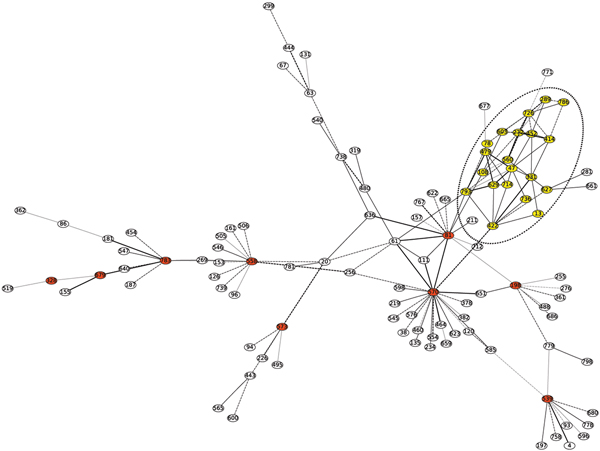
Undirected GGM network inferred from the Arabidopsis thaliana data using the algorithm of [7; 9]. The solid and dotted lines indicate positive and negative partial correlation coefficients, respectively, and the line intensity denotes their strength.